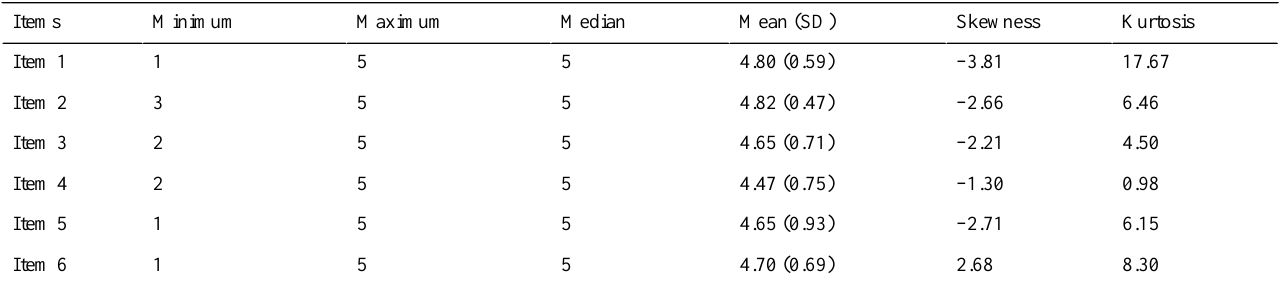
Table 2. Descriptive statistics for User Satisfaction Evaluation Questionnaire